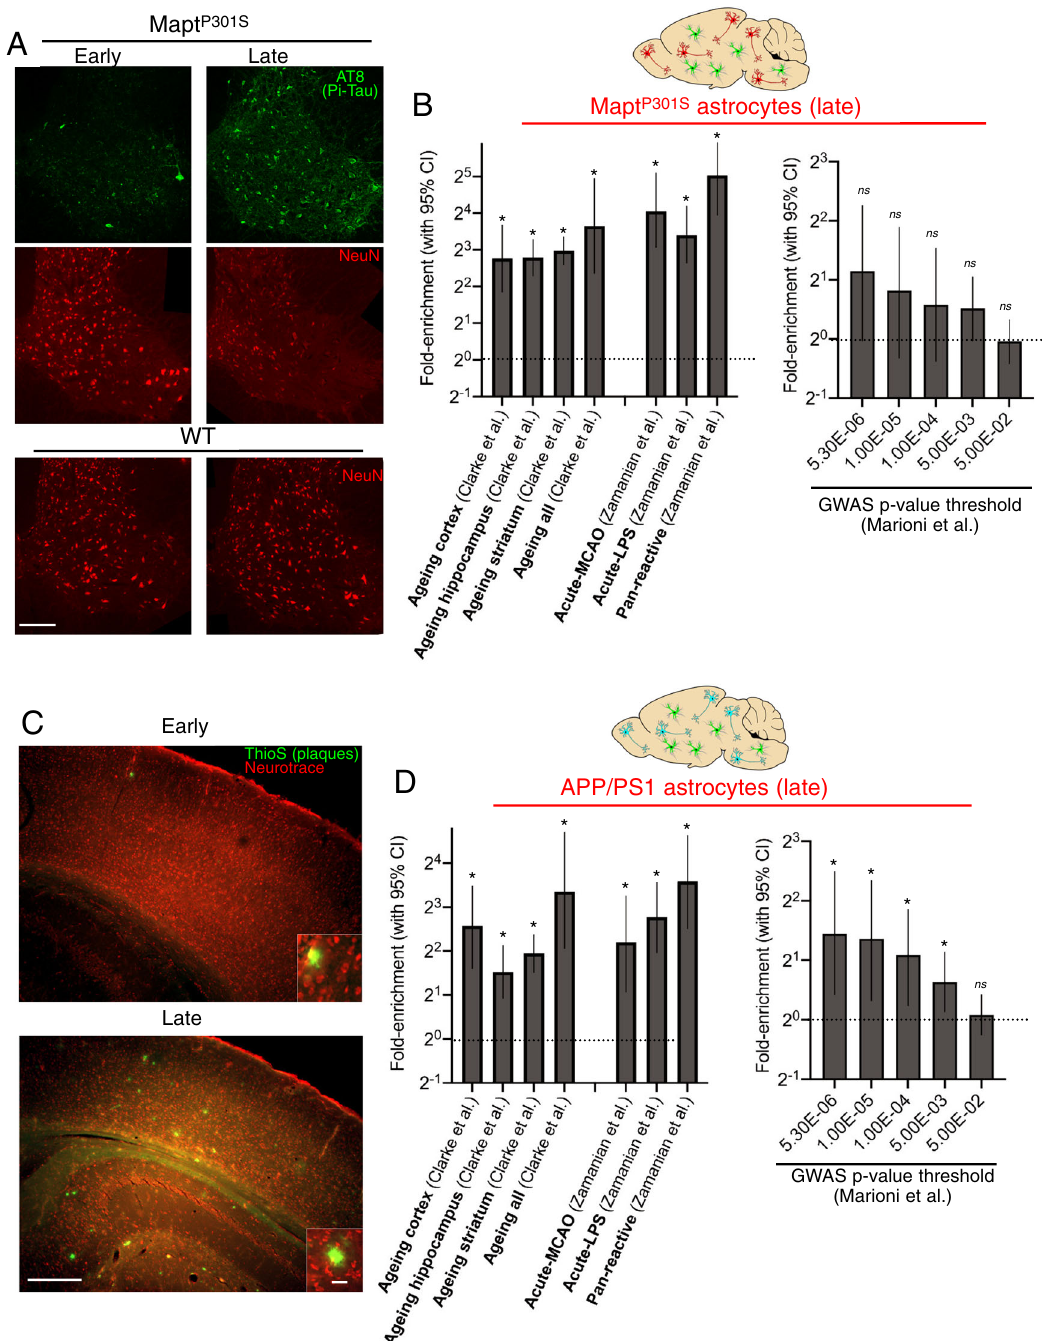
seq on astrocytes sorted (by MACS) from the cortices of trans- genic mice which overexpress Nrf2 (approximately threefold) speci fi cally in astrocytes 28 (GFAP-Nrf2), (Fig. 4B, Supplementary Data 7). We observed that of the core Aß/Tau-induced astrocytic genes, 29% were also induced in GFAP-Nrf2 astrocytes ( p < 0.05) and 21% (p_adj < 0.05), a near sixfold enrichment over chance (Fig. 4C, left) and a stronger enrichment than either Aß-induced or tau-induced gene sets separately (Fig. 4C, left). This is sug- gestive that Nrf2 is indeed part of a core response of astrocytes to Aß and Tau pathology and, consistent with this, genes induced in GFAP-Nrf2 astrocytes were also found to be enriched in genes upregulated in human AD astrocytes (Fig. 4C,